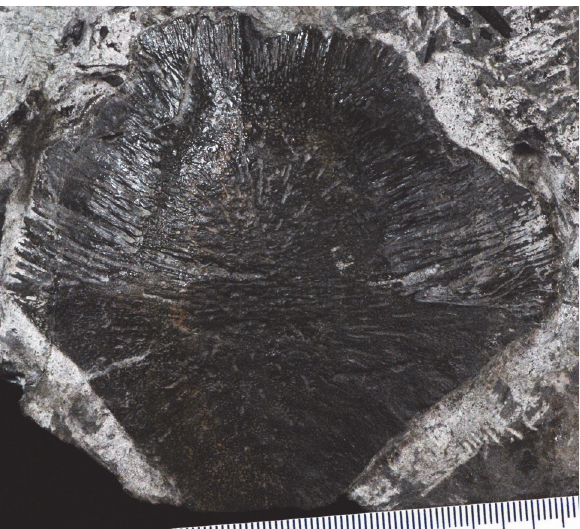
elements from Dora, Scotland.